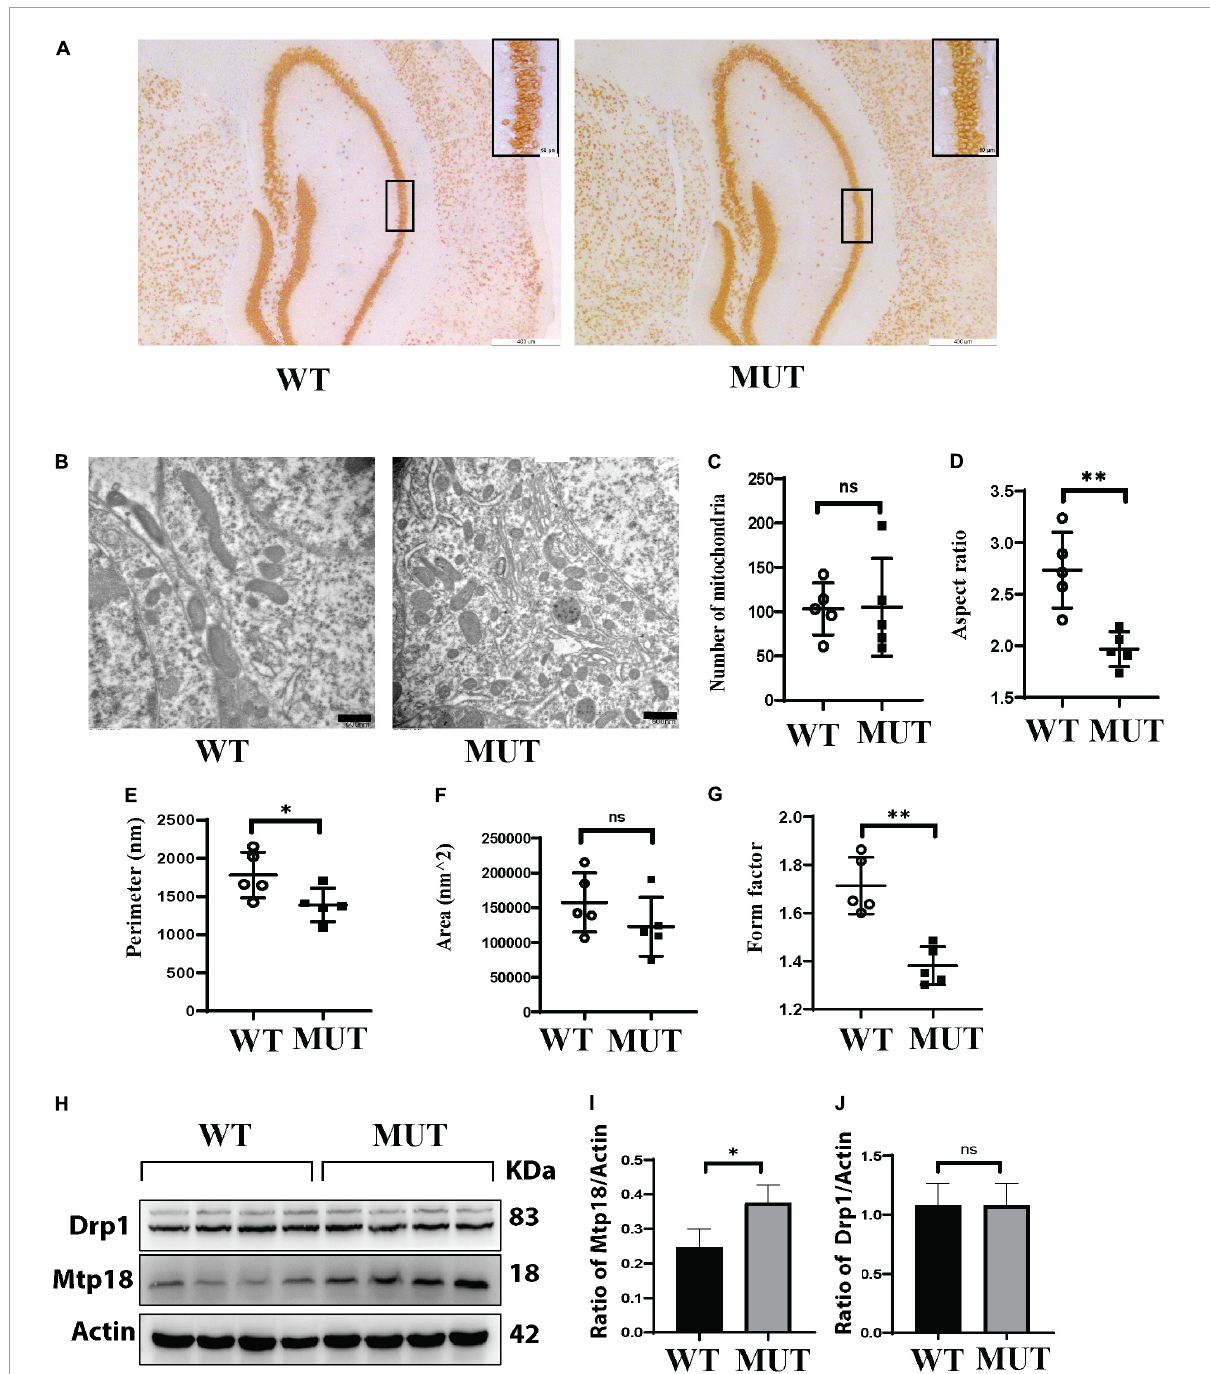
FIGURE5 A reduction in the mitochondrial size in the hippocampus of the Timm8a1 I 23 fs 49 X / I 23 fs 49 X MUT mice, correlated to upregulation of mitochondria fission protein Mtp18. (A) Histological immunostaining with an anti-NeuN antibody for neural cells in the hippocampus. (B) Electron microscopy (EM) images of the hippocampus. (C) There was no difference in the mitochondrial numbers between the two genotypes (WT = 103.20 ± 29.38, n = 5; MUT = 105.00 ± 55.22, n = 5, p > 0.05). (D) The aspect ratio was significantly decreased in the MUT mice (WT = 2.73 ± 0.36, n = 5; MUT = 1.96 ± 0.17, n = 5, ∗∗ p < 0.01). (E) The perimeter in the MUT mice was significantly shortened (WT = 1,780.17 ± 299.25, n = 5; MUT = 1,387.43 ± 219.27, n = 5, ∗ p < 0.05). (F) There was a tendency for less area in the MUT mice (WT = 157,451.33 ± 426,57.51, n = 5; MUT = 122,523.46 ± 423,66.67, n = 5, p > 0.05). (G) The form factor in the MUT mice was greatly reduced (WT = 1.71 ± 0.11, n = 5; MUT = 1.38 ± 0.07, n = 5, ∗∗ p < 0.01). (H) Western blotting for the wild-type (WT) and MUT mice at 8 weeks old. (I) Mtp18/Actin is upregulated in MUT mice (WT = 0.25 ± 0.05, n = 4; MUT = 0.38 ± 0.05, n = 4, ∗ p < 0.05). (J) There was no difference in dynamin-related protein 1 (Drp1)/Actin between the WT and MUT mice (WT = 1.08 ± 0.19, n = 4; MUT = 1.01 ± 0.09, n = 4, p > 0.05). Error bars represent mean ±